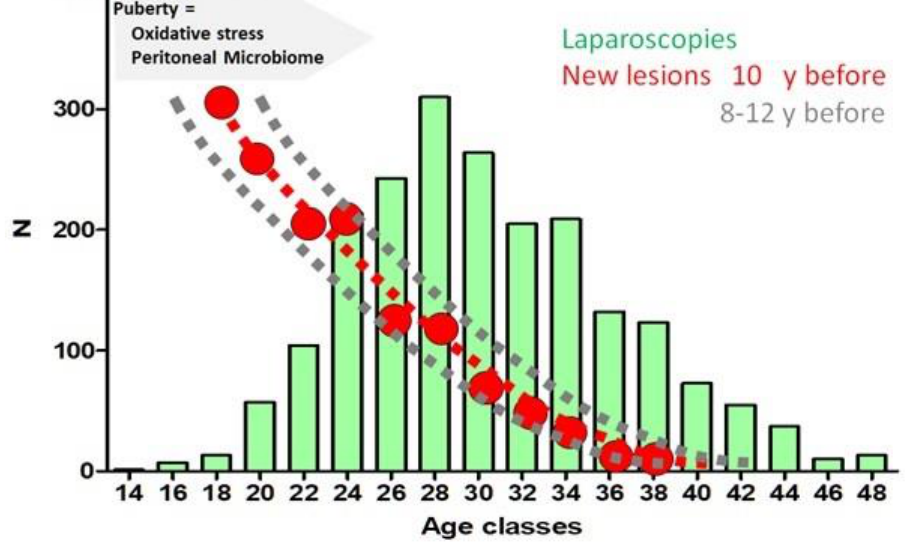
Figure 3. During adolescence the risk of initiating endometriosis is highest with a progressive decline thereafter. After puberty the endocrinology, and the oxidative stress of retrograde menstruation and the peritoneal microbiome change. Susceptible women will initiate endometriosis earlier while the remaining group will have a lower risk. Considering a 5 to 10 years delay between the initiation of endometriosis and the laparoscopy explains that most laparoscopies for endometriosis were performed between 25 and 30 years of age with an exponential decline thereafter (reproduced with permission